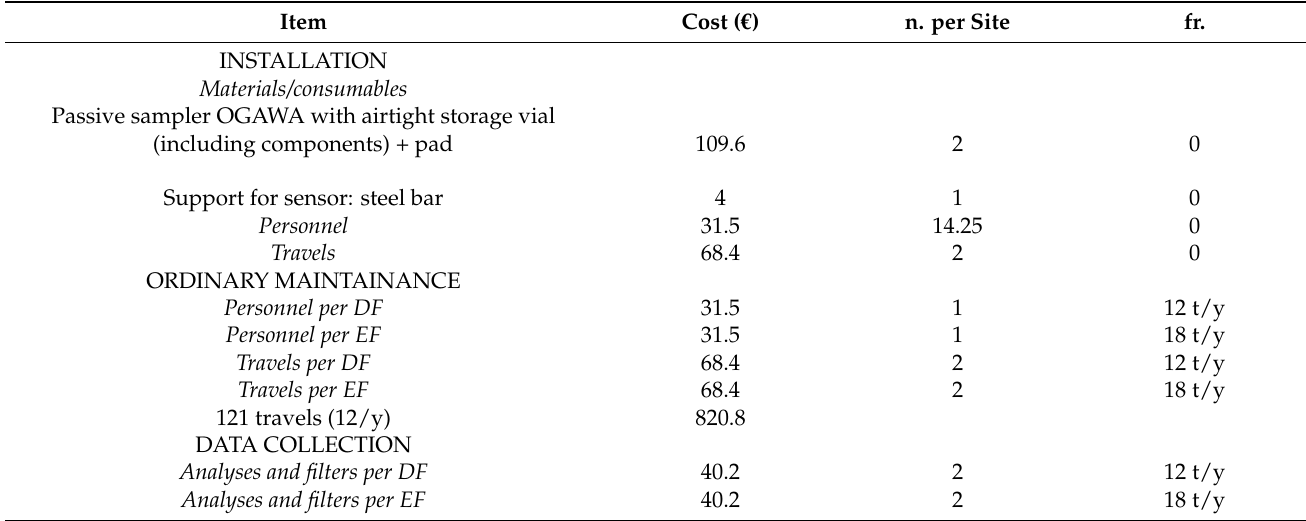
Table 5. Costs of passive monitoring station items with OGAWA sensors, listed separately per installation, ordinary maintenance, and data collection for deciduous forests (DF) and evergreen Mediterranean forests (EF). Extraordinary maintenance is not required.